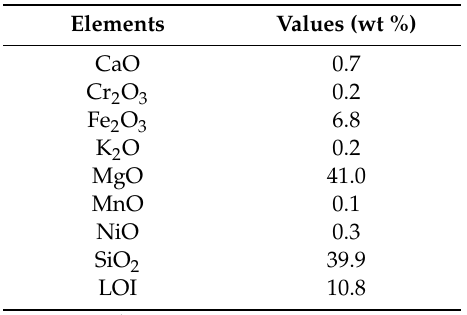
Table 2. Composition of the raw solid feedstock 1